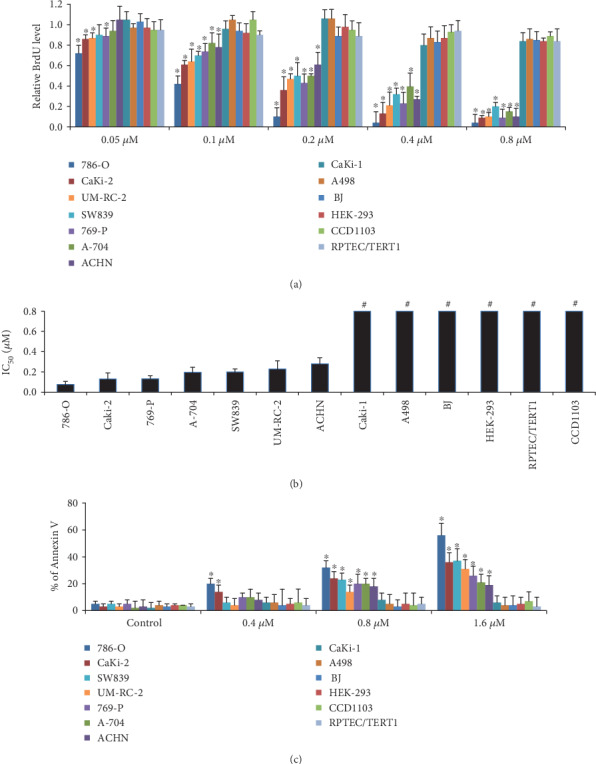
The sensitivity of RCC cancer cell lines and normal cells to ribociclib. (a) The differential antiproliferative effects of ribociclib in multiple RCC cell lines and normal cells. BJ is fibroblast cells. HEK-293, RPTEC/TERT1, and CCD1103 are normal kidney cell lines. 786-O, SW839, CaKi-2, CaKi-1, and A-498 are clear cell RCC cell lines. 769-P, A-704, UM-RC-2, and ACHN are renal adenocarcinoma cell lines. Results shown are relative to control (value set as 1). (b) IC50 values of ribociclib in RCC and normal cells. Cell lines are ordered from left to right with low to high IC50. # indicates that the IC50 value is more than the highest dose tested. (c) The differential proapoptotic effects (shown by % of Annexin V) of ribociclib in multiple RCC cell lines and normal cells. Cells were treated with the indicated doses for 72 h prior to proliferation and apoptosis analysis. ∗p < 0.05, compared to control (value is 1).